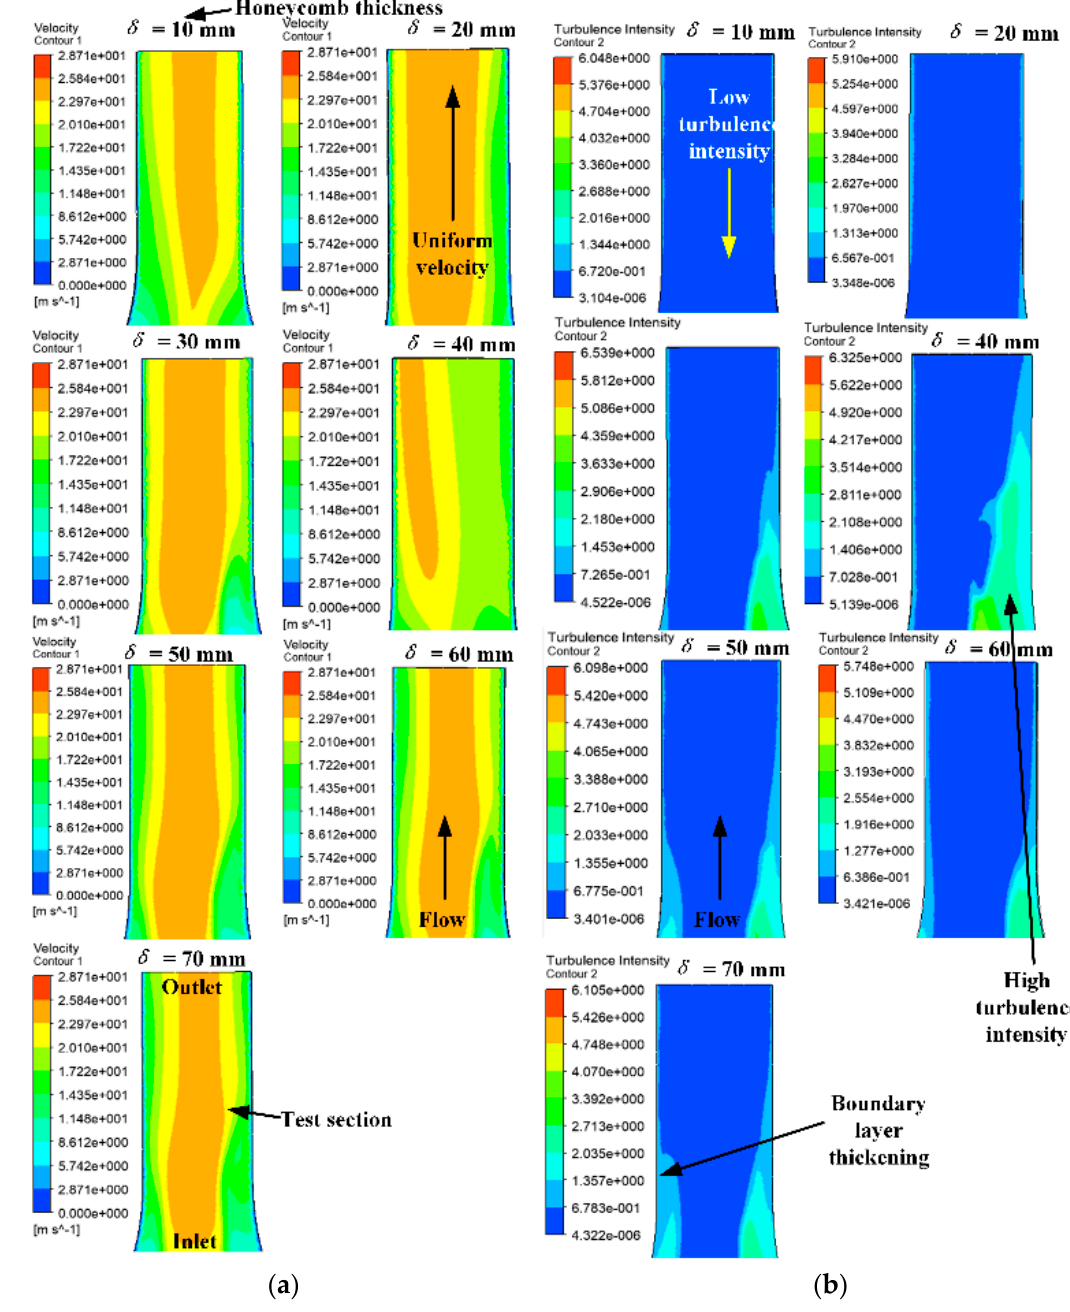
Figure 11. Velocity contour ( a ) and turbulence intensity contour ( b ) at various honeycomb thicknesses.